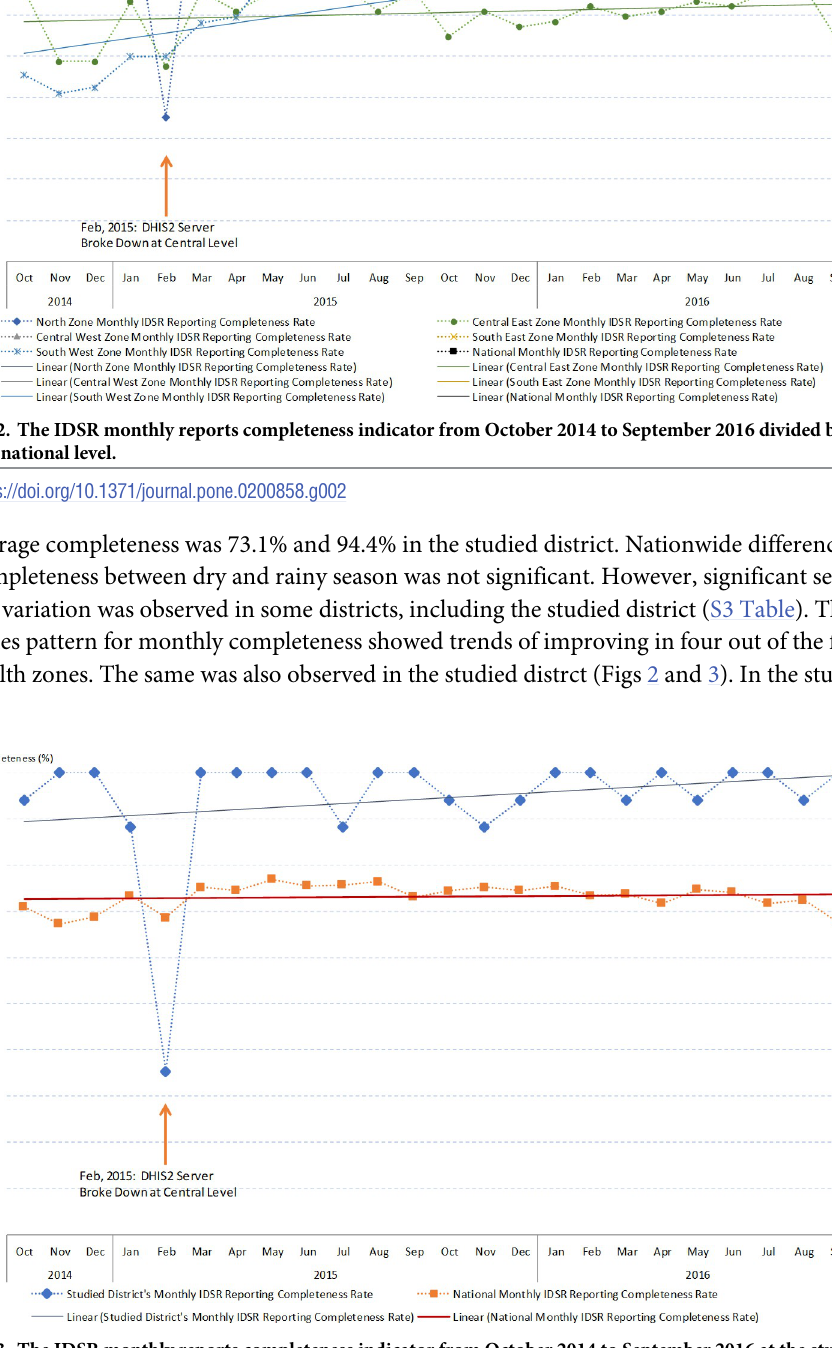
Fig 3. The IDSR monthly reports completeness indicator from October 2014 to September 2016 at the studied district and national